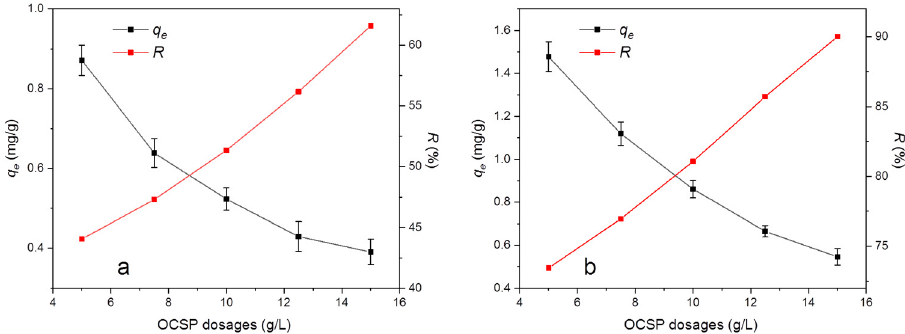
Figure 10. Effects of OCSP dosages of ( a ) bifenthrin and ( b ) cypermethrin on adsorption capacity and removal e ffi ciency.